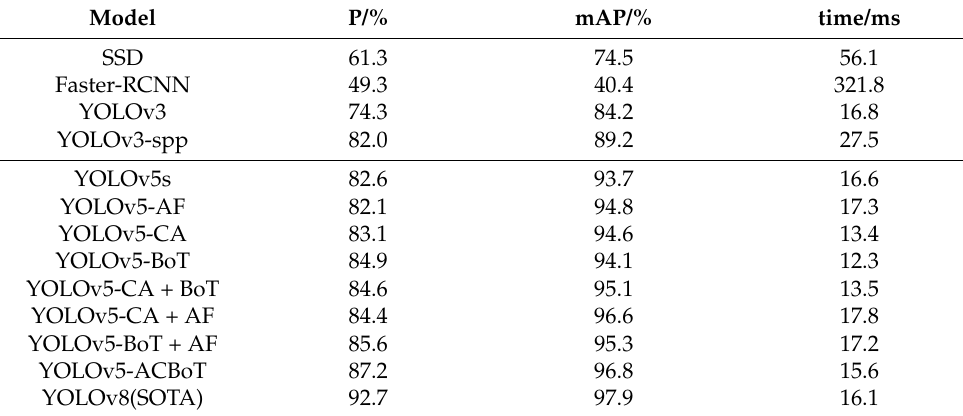
Figure 10. Comparison of partial detection results. Table 2. Comparison table of experimental